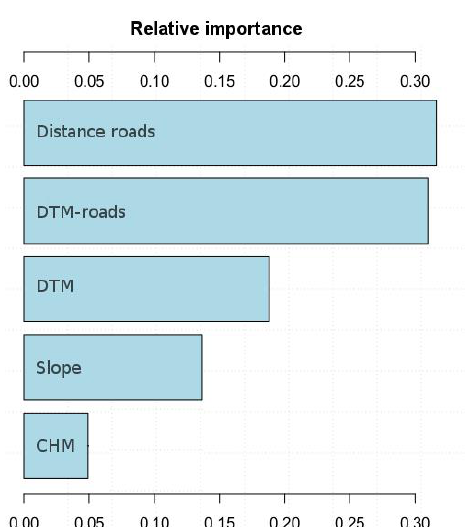
Figure 9. Relative Importance of the input variables using Ctree. The x-axis reports the AAD metric.